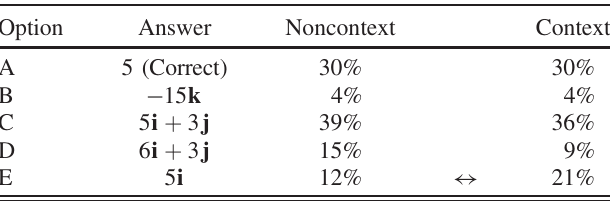
TABLE XV. Results of item 6: Students have to calculate the dot product of two vectors or force and displacement written